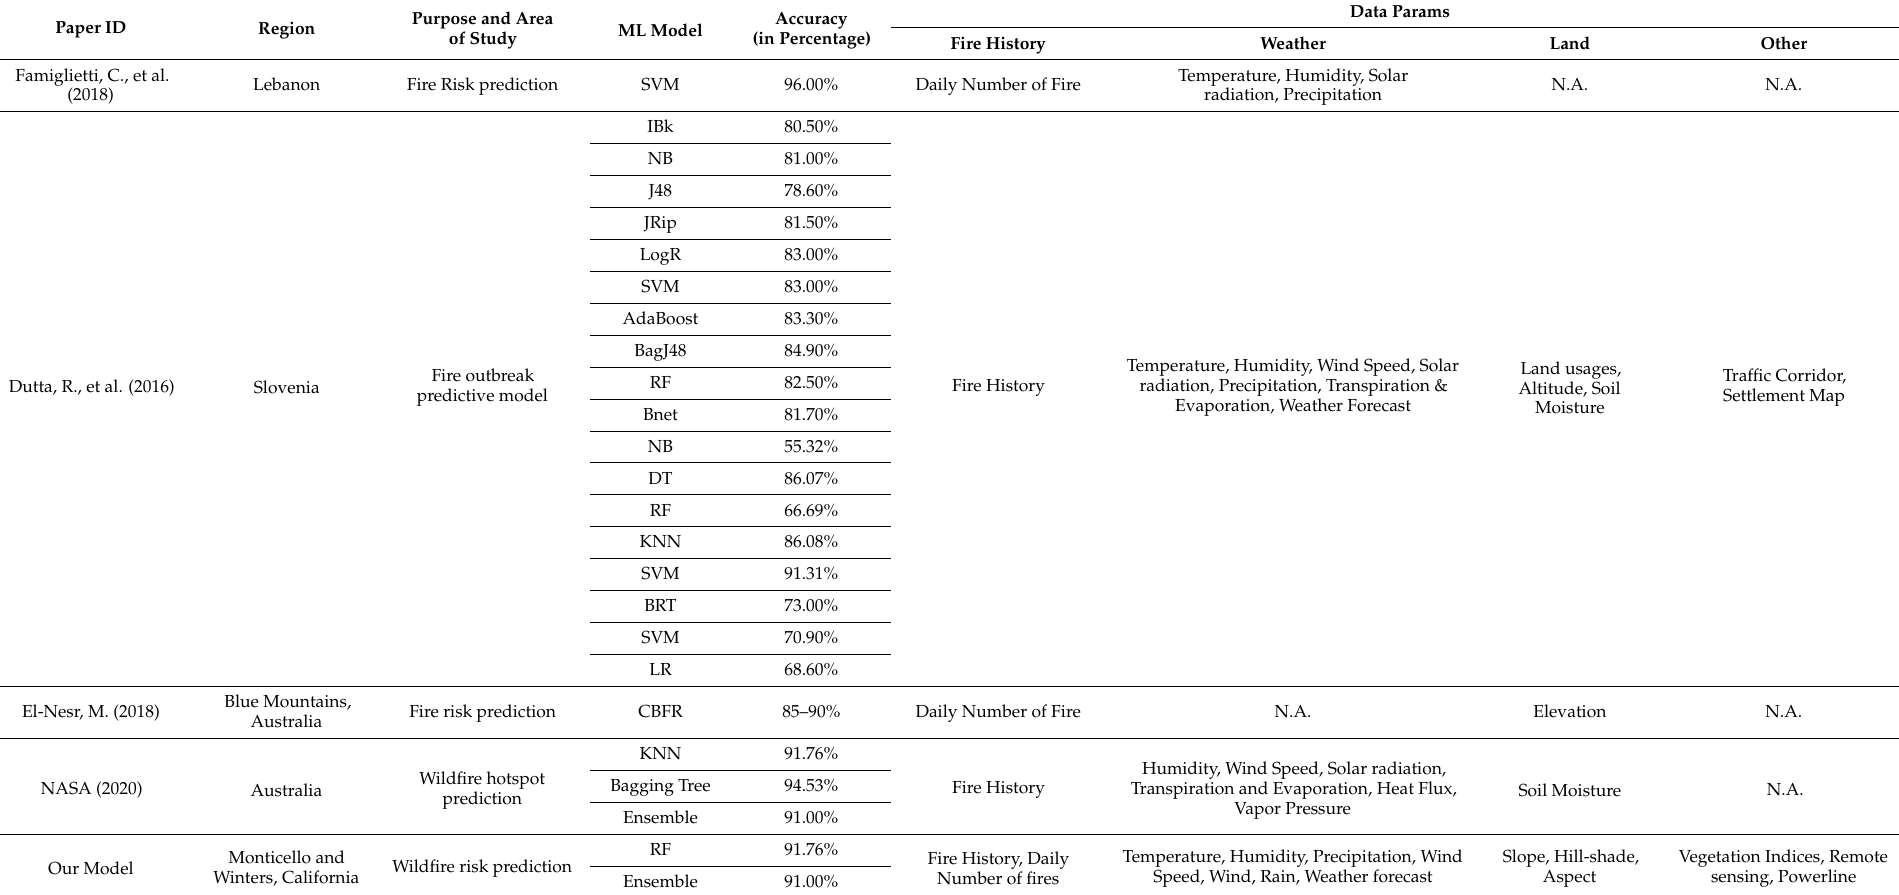
Table 1. A Comparison of Machine Learning Models in Wildfire